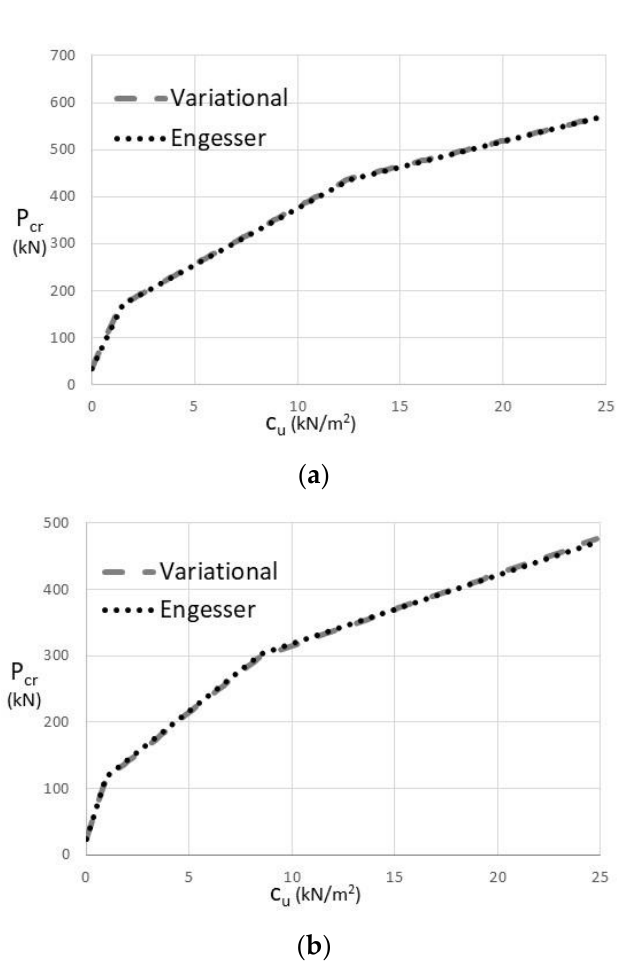
Figure 5. Comparison of critical buckling load calculation of piles (L = 4 m) in single-layered soil and different undrained shear strength: ( a ) Pile I [12] EI = 152.7, ( b ) Pile II [12] EI = 37.3 kN.m 2.